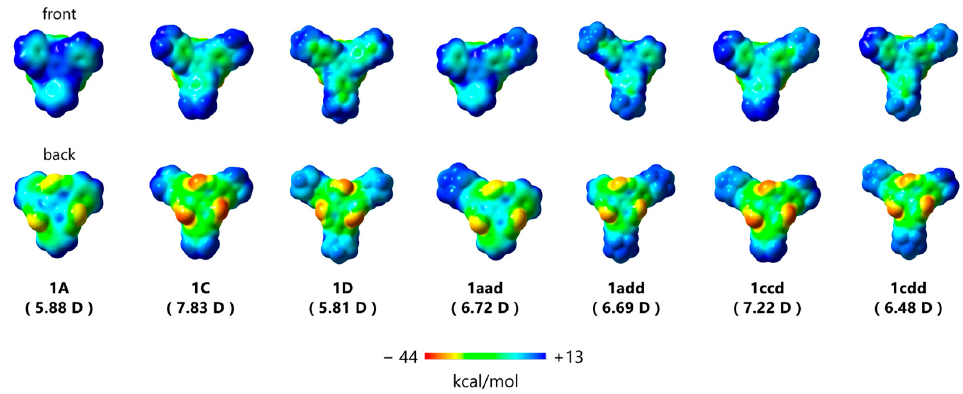
Figure 3. Electrostatic potential surfaces of 1A , 1C , 1D , 1aad , 1add , 1ccd , and 1cdd estimated em ‐ ploying quantum chemical calculations. Calculated values of the corresponding dipole moments [D = Debye] are shown in parentheses.